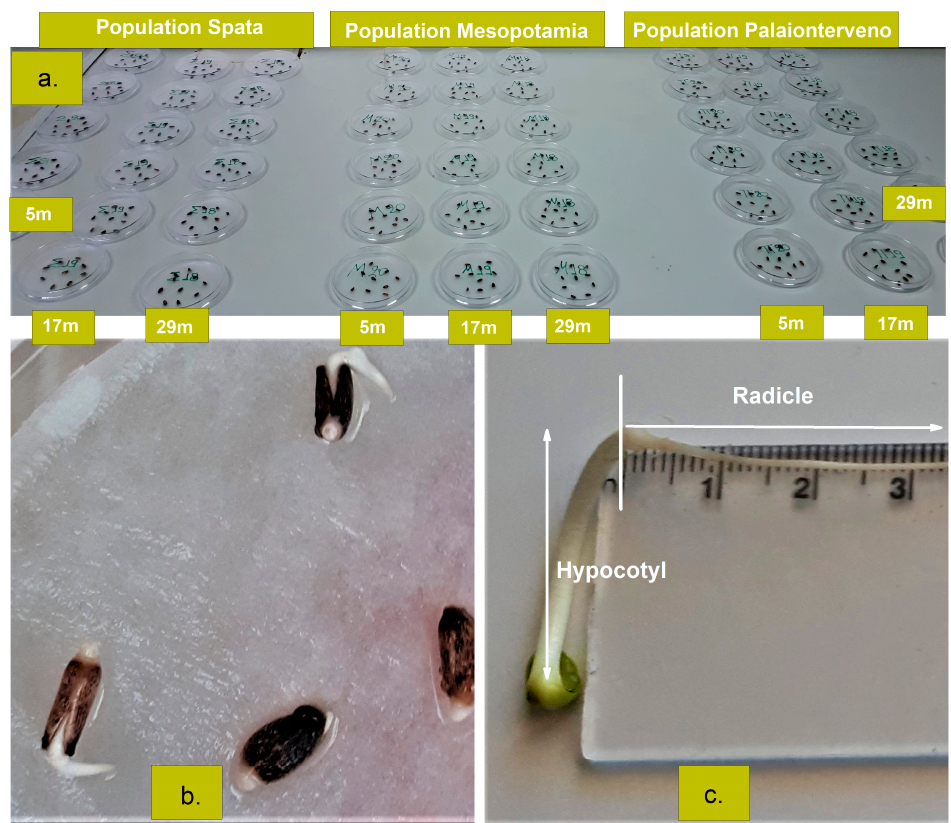
Figure 6. ( a ). Arrangement of the Petri dishes (diameter 9 cm, 10 seeds/dish, 60 seeds/treatment) for each milk thistle population (Spata, Mesopotamia, and Palaionterveno) before placement in the germination chamber (5, 17, and 29 refer to the months (m) of storage and the conditions that prevailed during storage). The equal number (54) of Petri dishes was used at each of the six tested temperatures (5 ◦ C, 10 ◦ C, 15 ◦ C, 20 ◦ C, 25 ◦ C, and 30 ◦ C). ( b ) Germinated seeds of milk thistle, and ( c ) Hypocotyl and radicle of seedling.